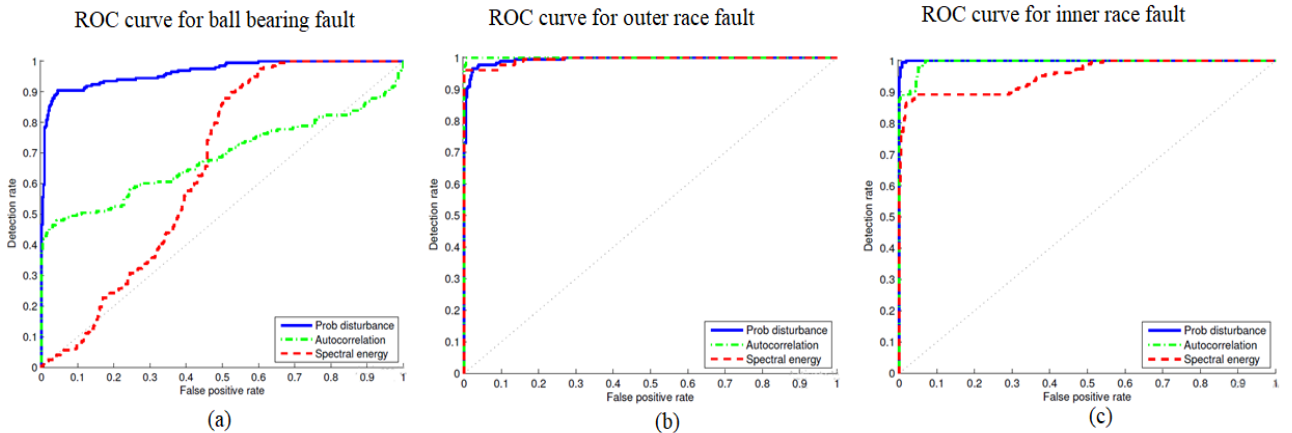
Figure 14. ROC curves for evaluating the performance of ( a ) ball bearing fault, ( b ) outer race fault, and ( c ) inner race fault. Reproduced with permission of [45].